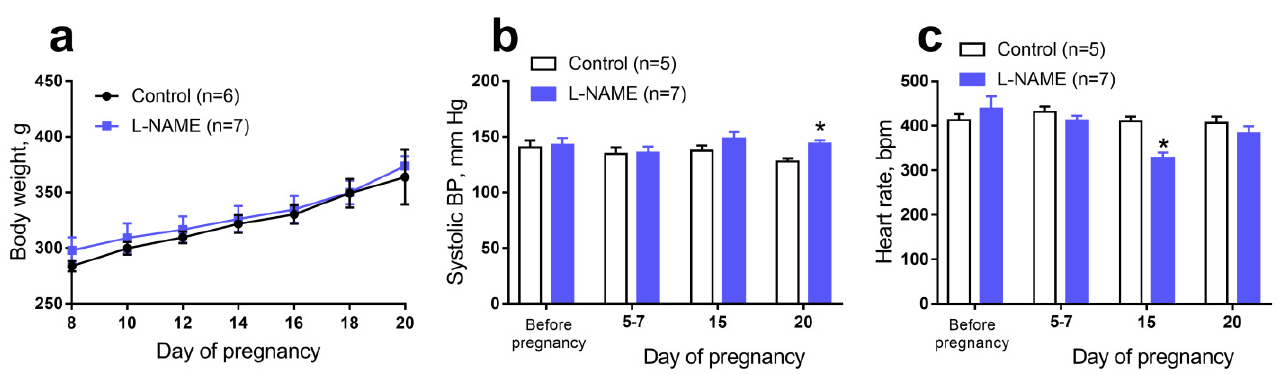
Figure 1. Characteristics of females from control and L-NAME groups. ( a ) Bodyweight gain during the pregnancy. ( b , c ) Systolic blood pressure (BP, b) and heart rate ( c ) before pregnancy, at gestational day (GD)5-7, GD15, and GD20; n —number of females. Data are presented as mean and S.E.M. * p < 0.05 (Unpaired Student’s t -test). Table 1. Bodyweight (BW), organ weights as well as concentrations of NO metabolites in serum of 1-day-old rat pups from control and L-NAME